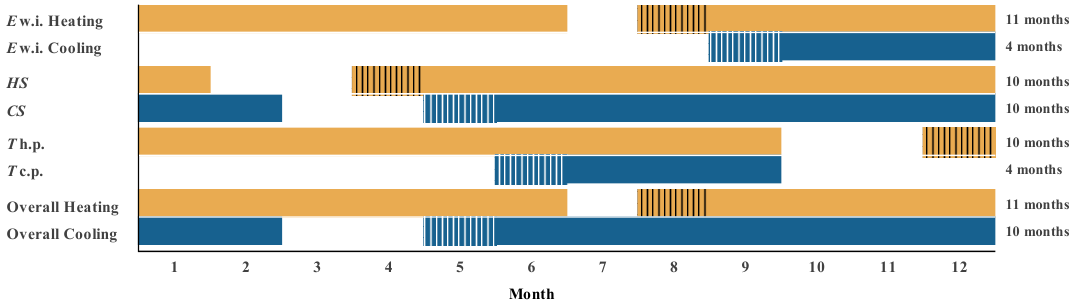
Figure 8. Comparison of the best periods from ranking #2 for unit #602.